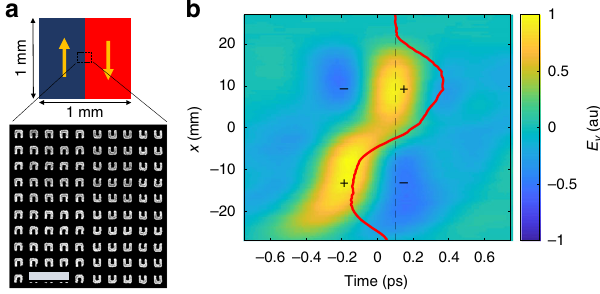
Fig. 3 Generation of single-cycle Hermite – Gauss wavepacket. a Structure of nonlinear metasurface (NLMS) for generation of Hermite-Gauss(1,0) ( HG 10 ) single-cycle terahertz beam. Arrows indicate the orientation of the split-ring resonators. Scanning electron microscope image of the center of the NLMS is shown in the enlarged picture. Scale bar is 1 μ m. b Spatiotemporal pro fi le of the single cycle HG 10 beam emitted from the NLMS in a . Spatial fi eld pro fi le along the dashed line is plotted in red. The ± signs mark the lobes of spatiotemporal quadrupole structure formed on the xz